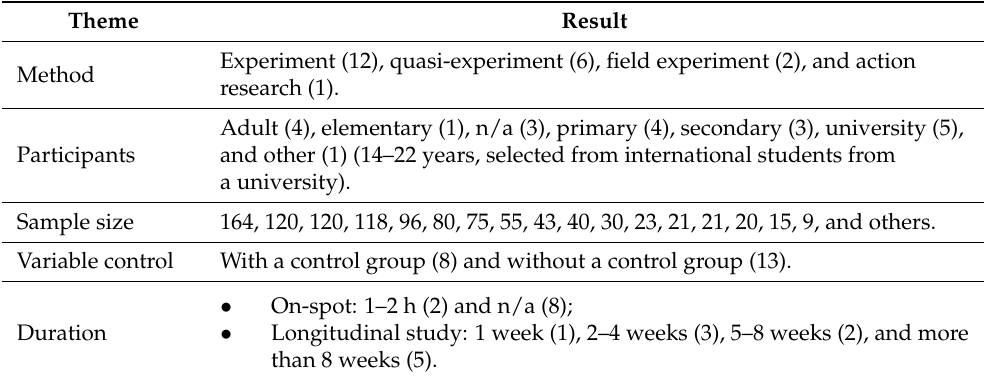
Table 3. Methodological features of the selected empirical studies. Theme